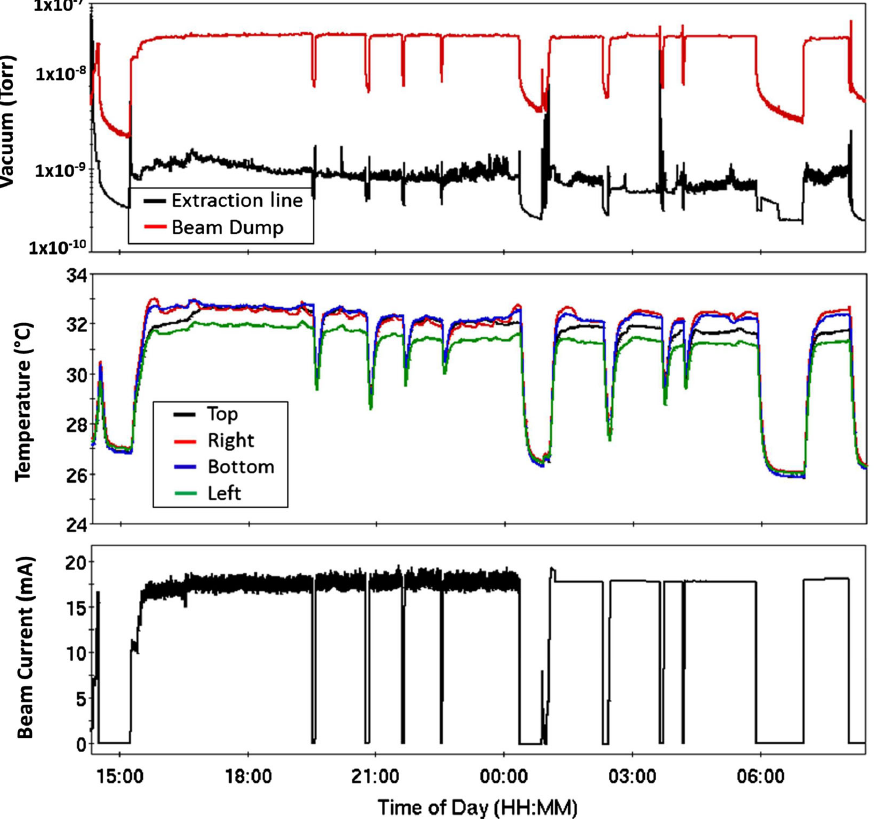
FIG. 12. High-current 9 MHz CW operation to the high-power beam dump at the end of run 2019 with an average beam current of up to 18 mA and 2 MeV kinetic energy. Top: Vacuum in the extraction line and near the beam dump. Middle: Temperatures of the different sides of the beam dump entrance pipe. Bottom: Beam current measured by the DCCT. Intensity feedback was turned on at 01:00 AM, and the fast intensity fluctuations were reduced from 5 × 10 − 2 to 5 × 10 − 4 peak to peak.